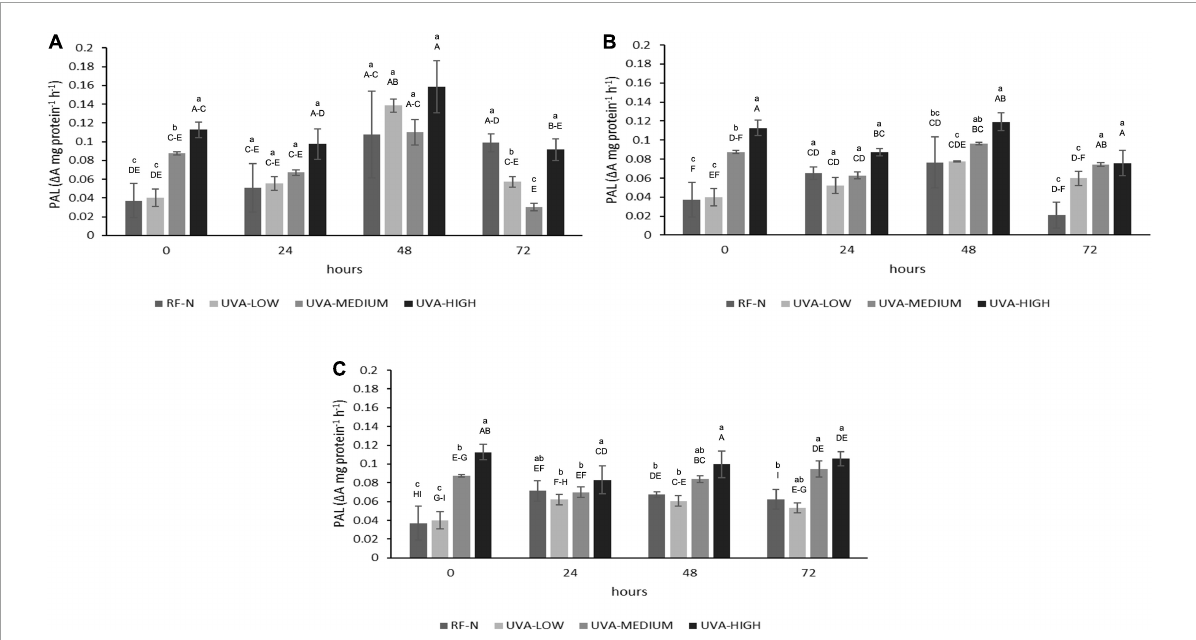
FIGURE1 Phenylalanine ammonia-lyase (PAL) activity of UVA-treated strawberry by-products during storage at (A) 5 ◦ C, (B) 10 ◦ C, and (C) 15 ◦ C. RF-N: Strawberry agro-industrial by-product control. UVA-LOW: RF irradiated with 28.8 KJ/m 2 . UVA-MEDIUM: RF irradiated with 57.6 KJ/m 2 . UVA-HIGH: RF irradiated with 86.4 KJ/m 2 Different lower-case letters mean significant differences ( p ≤ 0.05) among treatments at the same storage time. Different capital letters mean significant differences ( p ≤ 0.05) among different storage